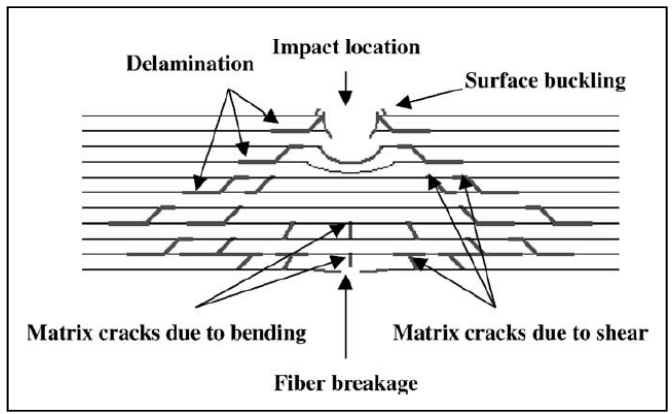
Figure 2. Schematic representation showing a typical impact damage mode for